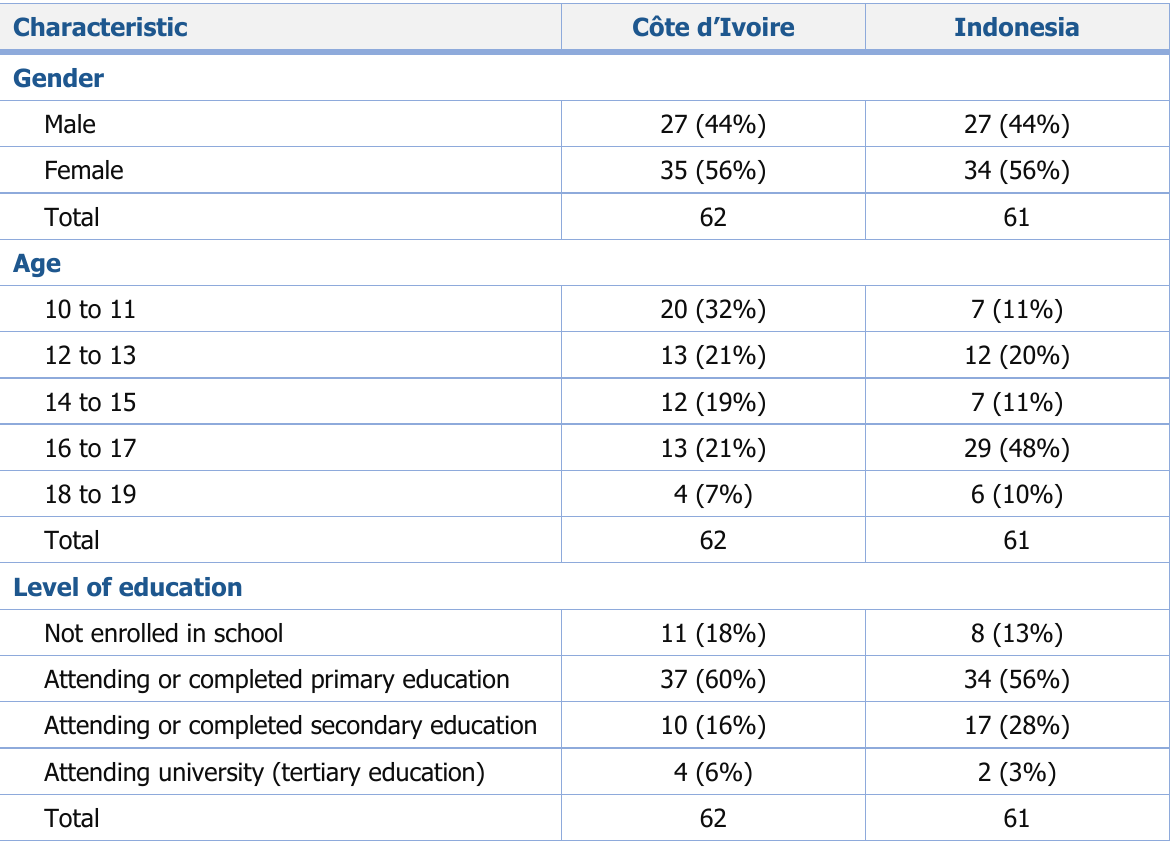
Table 2. Participant